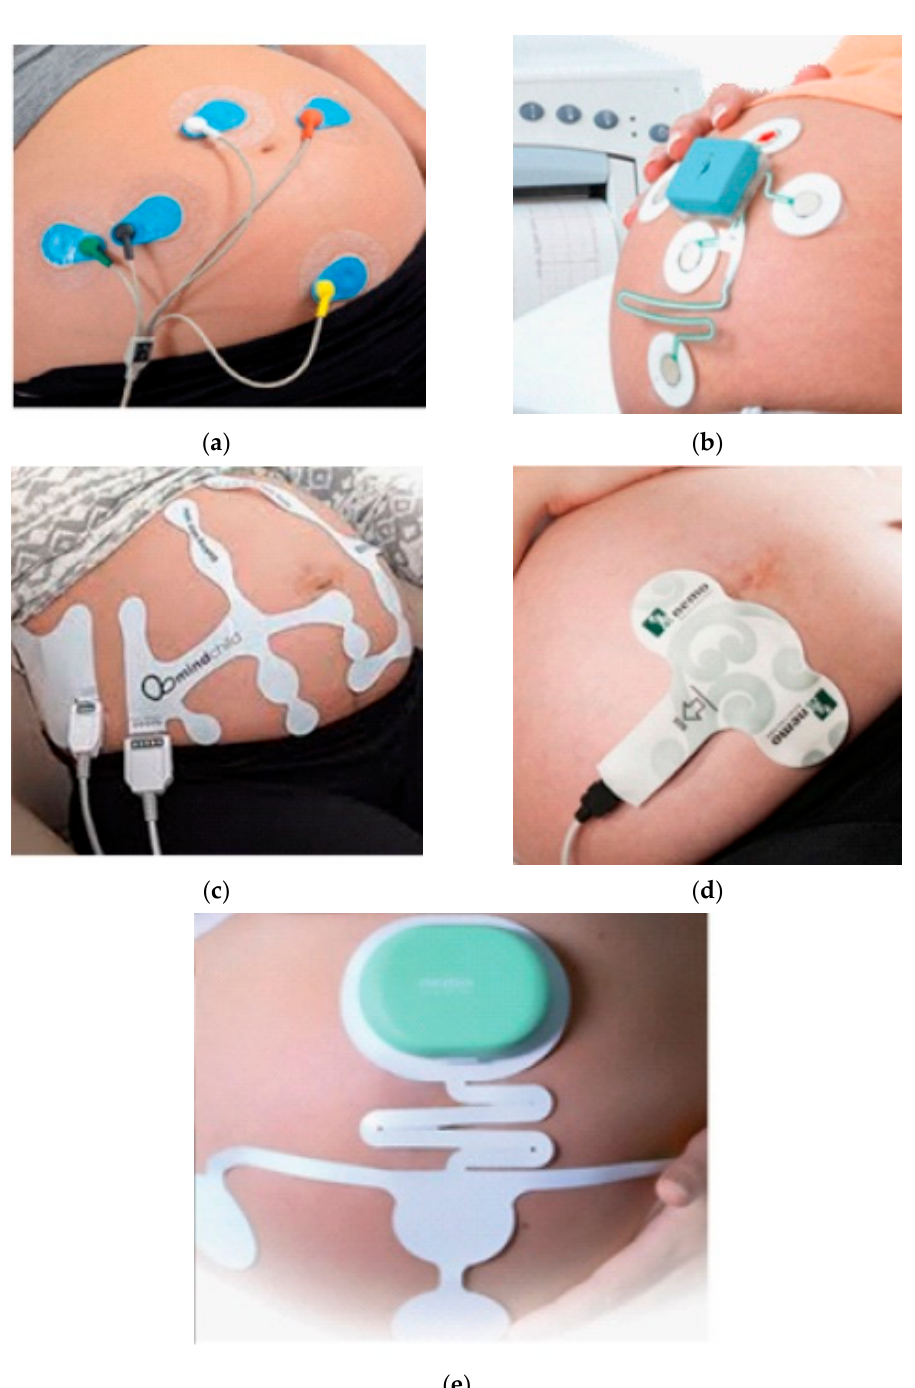
Figure 8. Examples of CE/FDA-certified commercially available NIFECG-based devices [69]. ( a ) Monica AN24, ( b ) Monica Novii Wireless Patch System, ( c ) MERIDIAN M110 Fetal Monitoring System, ( d ) PUREtrace, ( e ) Nemo Fetal Monitoring System (Reprinted with permission from Radek Martinek (2019) (2019, Creative Commons License).